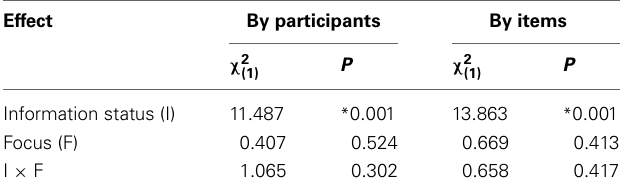
Table 4 | Generalized-Score Chi-Squares from binary logistic GEE analyses, predicting the likelihood of be-passive responses by factor combinations of Information Status (given Agent or given Patient) and Focus (Agent or Patient cleft).